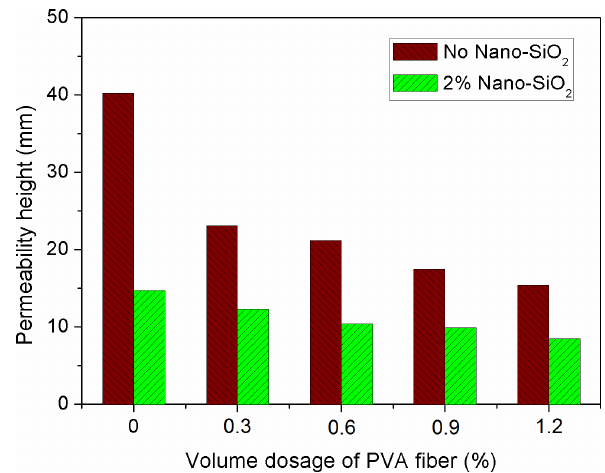
Figure 3: Effect of PVA fiber on permeability height